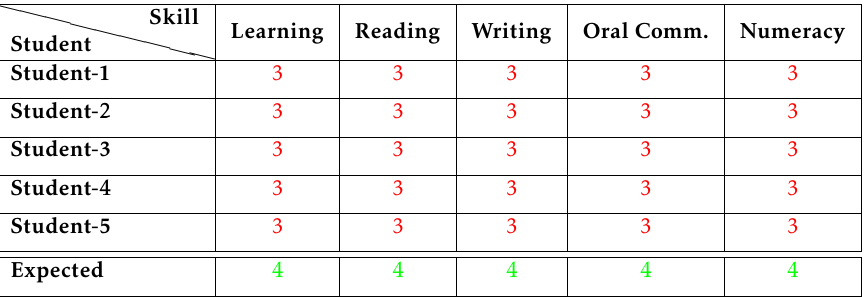
Table 2. LLN Test Results of Diploma of Software Development Students